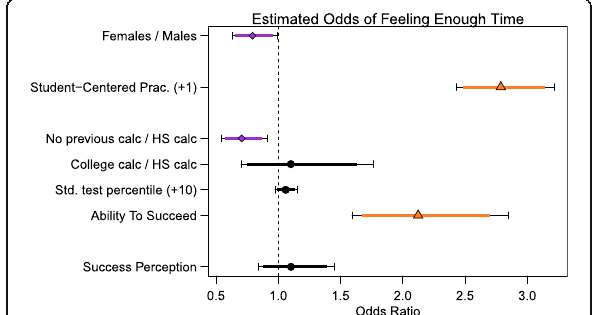
Fig. 1 Student results. Estimated effects of the student factors on the odds that a student reported there was enough time in class to understand difficult ideas. The points represent the best estimate of the odds ratio, and the intervals represent the 90% (smaller, colored or black ) and 95% (wider, black ) confidence intervals for the ratios. Statistically significant odds ratios greater than one are shown in orange with triangle points and indicate students with higher levels of this factor are more likely to respond that there was enough time.